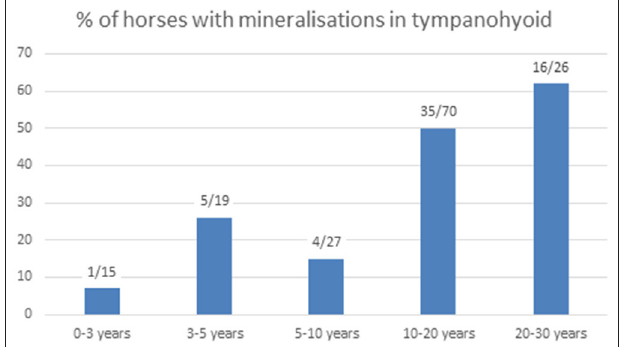
FIGURE 3 | Number of horses with mineralization in the tympanohyoid and percentage in the different age groups.